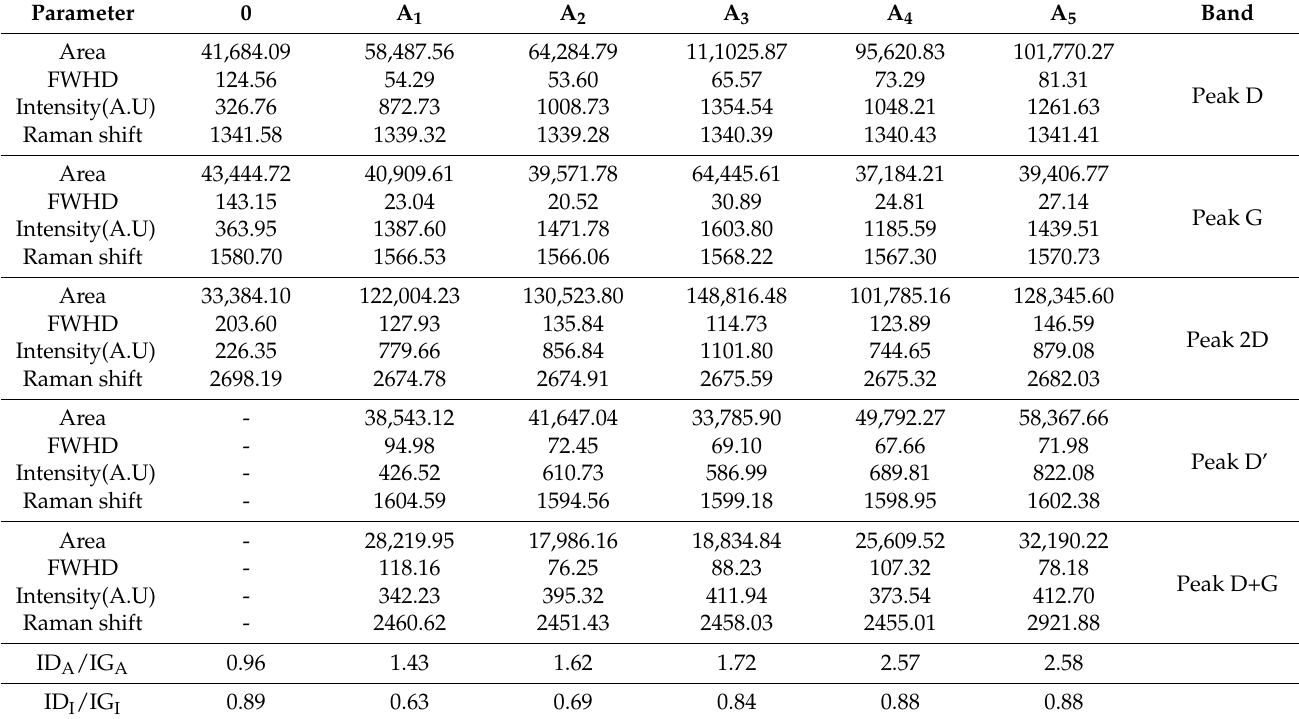
Table 5. Summary of the positions of individual bands and the values of the I DA /I GA and intensity ratios of the D and G (I D/ I G )